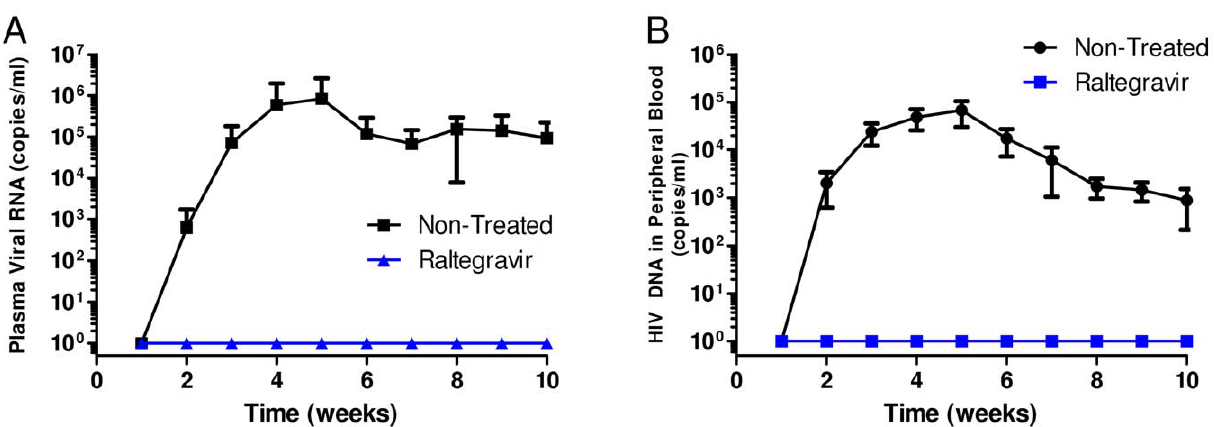
Figure 2. RNA and DNA viral loads in mice administered with raltegravir. RAG-hu mice were challenged by vaginal route after oral administration of raltegravir as described in Methods. Blood was collected weekly. Viral RNA was extracted from the plasma fraction and DNA was extracted from the cellular fraction. Viral RNA and DNA loads were determined by Q-RT-PCR as described in methods. A. RNA viral loads B. DNA viral loads.